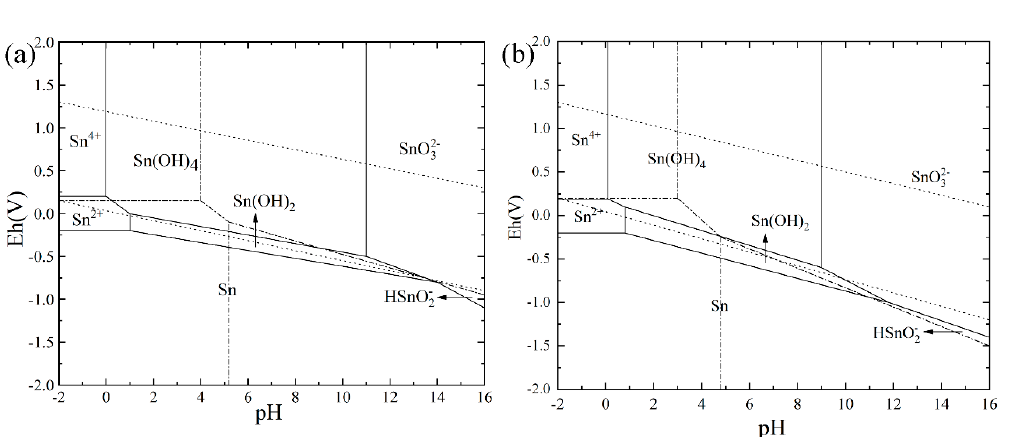
Figure 6. E-pH diagrams of Sn-H 2 O systems at ( a ) 25 °C and ( b ) 100 °C.